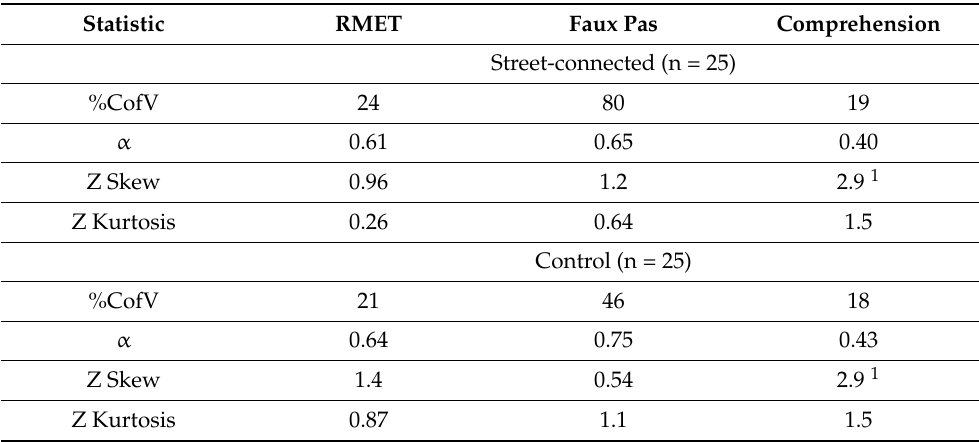
Table 1. Psychometric properties of the of theory of mind tasks and verbal comprehension in the matched pairs of street-connected and control participants. Statistic RMET Faux Pas Comprehension Street-connected (n = 25) %CofV 24 80 19 α 0.61 0.65